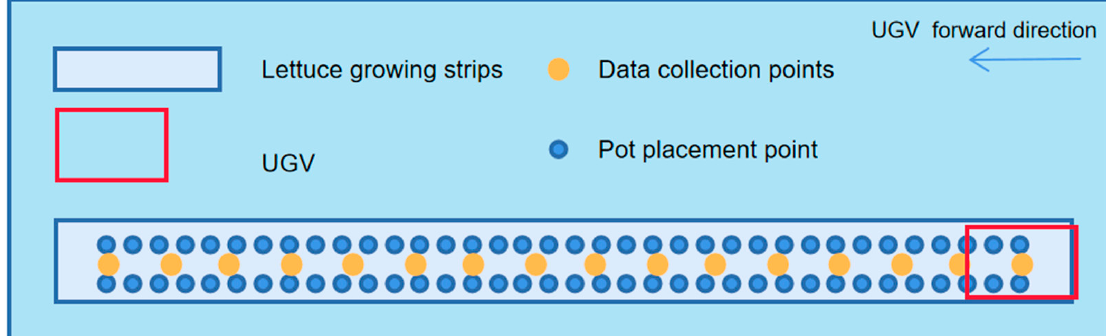
Figure 5. Schematic of UGV-LiDAR phenotyping platform for data acquisition.